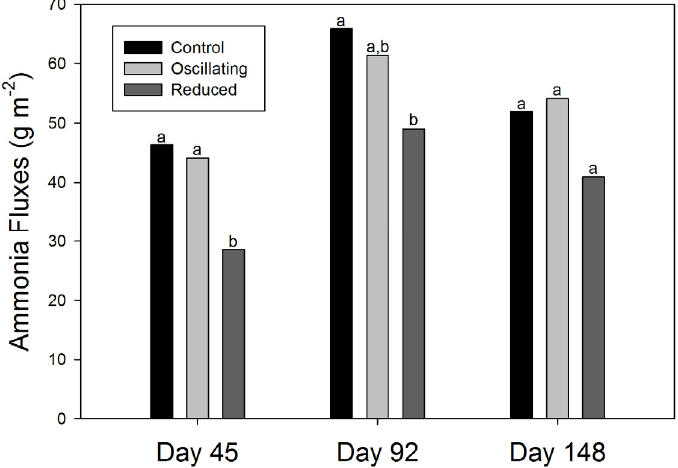
Figure 4. Cumulative (7-day) ammonia fluxes for each of the sampling days and each of the dietary CP treatments. Control: 13.5% CP; Oscillating N: 13.5% CP 4 days/week and 11.62% CP 3 days/week; and Reduced N: 11.62%